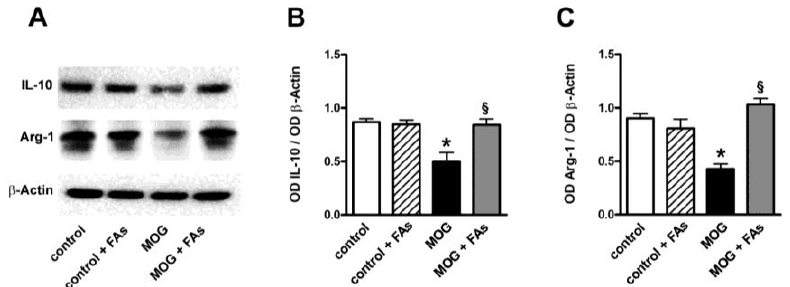
Figure 3. Dietary supplementation with FAs prevents MOG-induced downregulation of both IL-10 and Arg-1. ( A ) Representative blots from retinal homogenates of control and MOG-treated mice, with or without FAs supplementation. Protein levels of IL-10 ( B ) and Arg-1 ( C ) were evaluated by Western blot using β-actin as loading control. Data from densitometric analysis are shown as the mean ± S.E.M. ( n = 9 for each experimental group). * p < 0.001 versus control. § p < 0.001 versus MOG (One way ANOVA followed by the Newman–Keuls multiple comparison post-hoc test). White bars, control mice; dashed bars, control mice with FAs supplementation; black bars, MOG-treated mice; grey bars, MOG-treated mice with FAs supplementation.